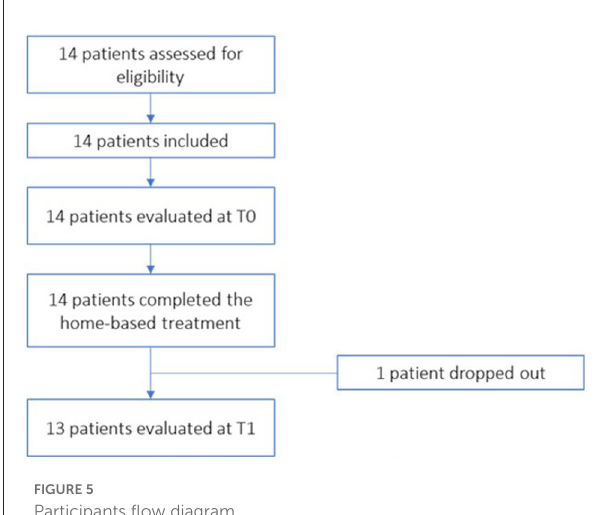
FIGURE5 Participants flow diagram.